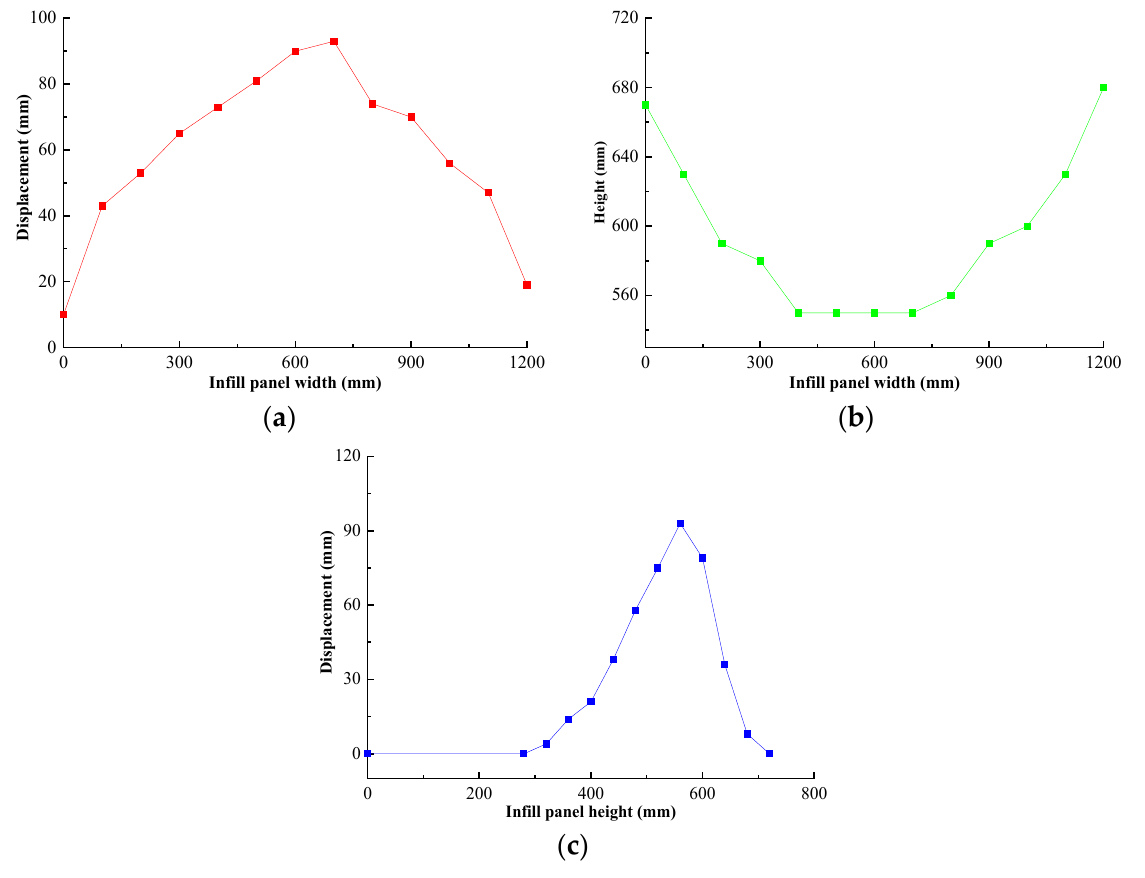
Figure 32. Deformation diagram of the infill panel for specimen 2: ( a ) Out-of-plane displacement in the width direction; ( b ) Height at the maximum displacement; ( c ) Deformation at the middle part of infill panel.